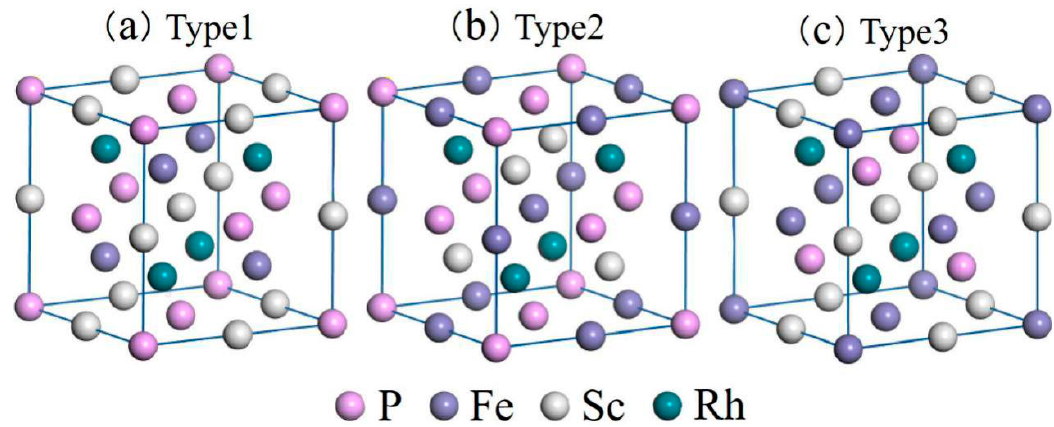
Figure 2. Three possible crystal structures ( a ) type 1, ( b ) type 2, ( c ) type 3 for ScFeRhP compound. Table 1. Three crystal-structure atomic positions of the ScFeRhP equiatomic quaternary Heusler (EQH) compound.